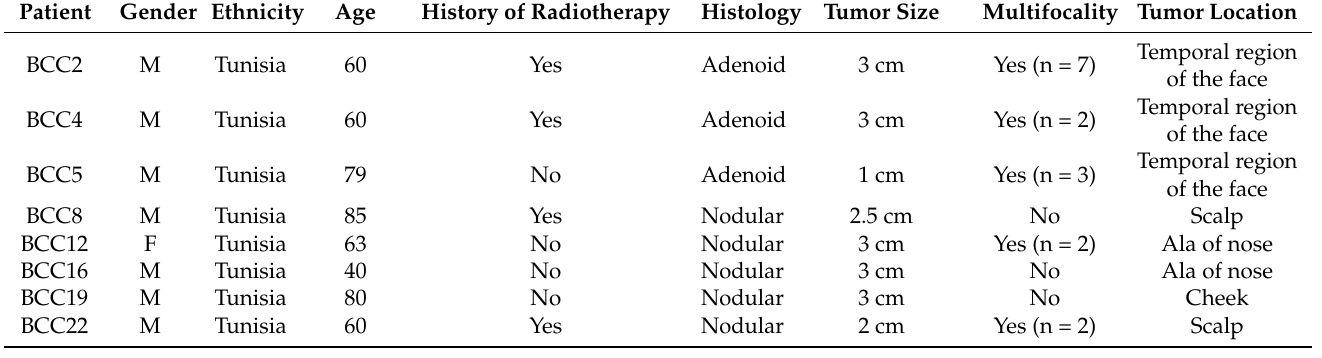
Table 1. Patients’ characteristics.